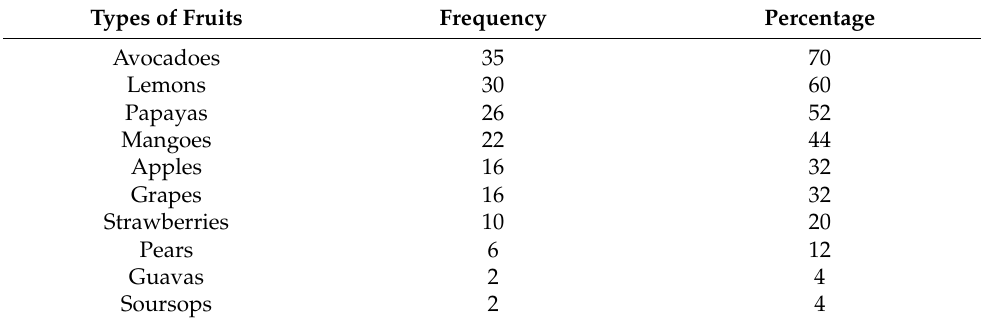
Table 2. Distribution of the fruit species sold by the respondents ( n = 50).